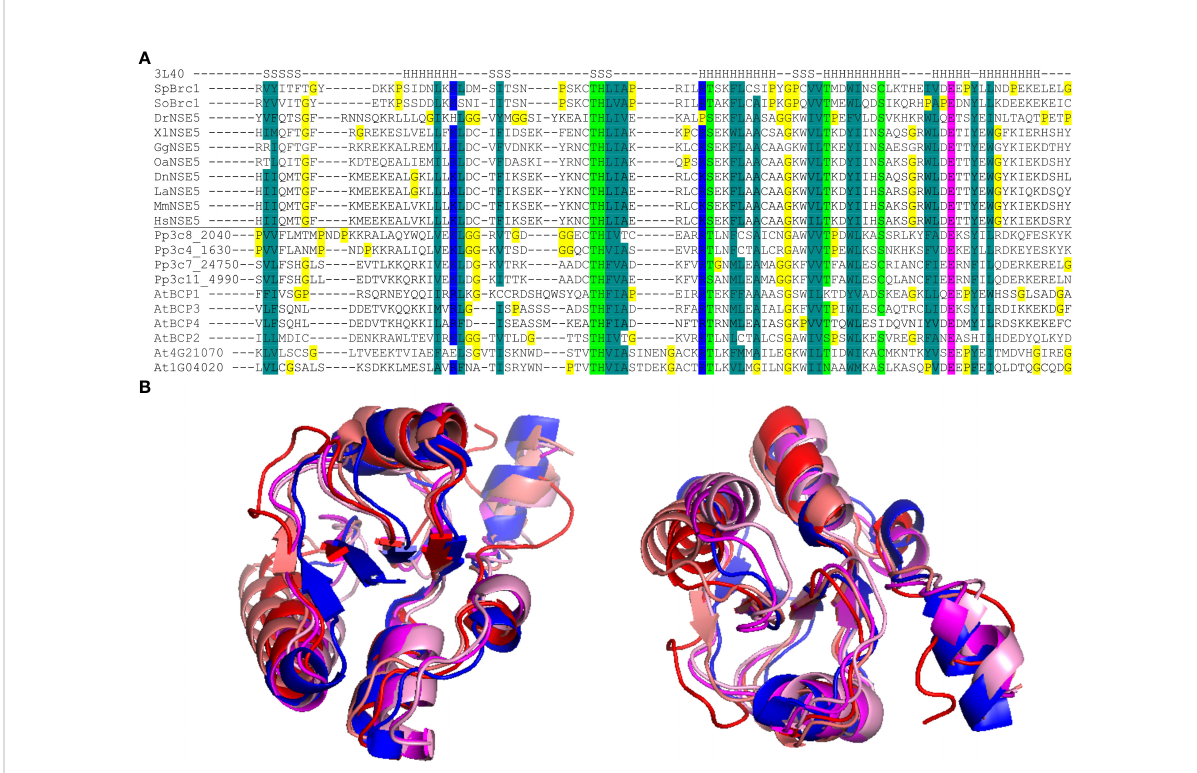
FIGURE 1 BRCT5 domain analysis. (A) Alignment of the core part of the BRCT5 domain with helical (H) and b -strand (S) segments above (from PDB: 3L40 structure; Williams et al., 2010). The Brc1 and NSE5 orthologs are from Schizosaccharomyces pombe ( Sp ), S. octosporus ( So ), Physcomitrium patens ( Pp ), Arabidopsis thaliana ( At ), Danio rerio (Dr), Xenopus laevis ( Xl ), Gallus gallus ( Gg ), Ornithorhynchus anatinus ( Oa ), Monodelphis domestica ( Md ), Dasypus novemcinctus ( Dn ), Loxodonta africana (La), Mus musculus ( Mm ), Homo sapiens ( Hs ). Coloring indicates amino acid groups conserved across the family: dark green , hydrophobic and aromatic; light green , polar; blue , acidic; pink , basic; all glycine and proline residues are highlighted in yellow . (B) Superimposition of modeled BRCT5 domains of At4g02110 (red), At2g41450 (deep pink), At4g03130 (coral), At3g21480 (pale pink), and crystal structure Sp Brc1 (blue) shown from two